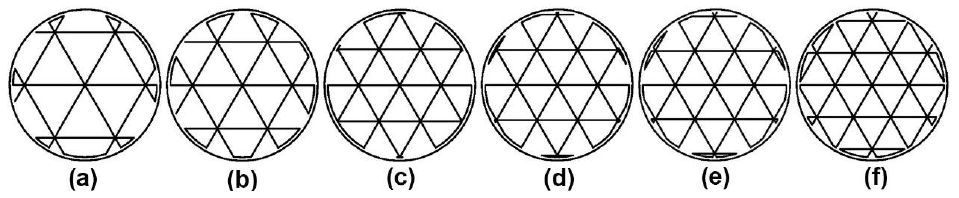
Figure 2. Tracing patterns of triangular fill with different infill densities. ( a ) 28%; ( b ) 34%; ( c ) 41%; ( d ) 42%; ( e ) 43%; ( f ) 46%. Secondly, the rectangular fill follows two tracing patterns which rotate 90 degrees to each other. Take 31% rectangular fill, where the even layers follow Figure 3a and the odd layers (starting from the third layer) follow Figure 3b. The odd-layer tracing patterns of other infill densities are also shown in Figure 3.